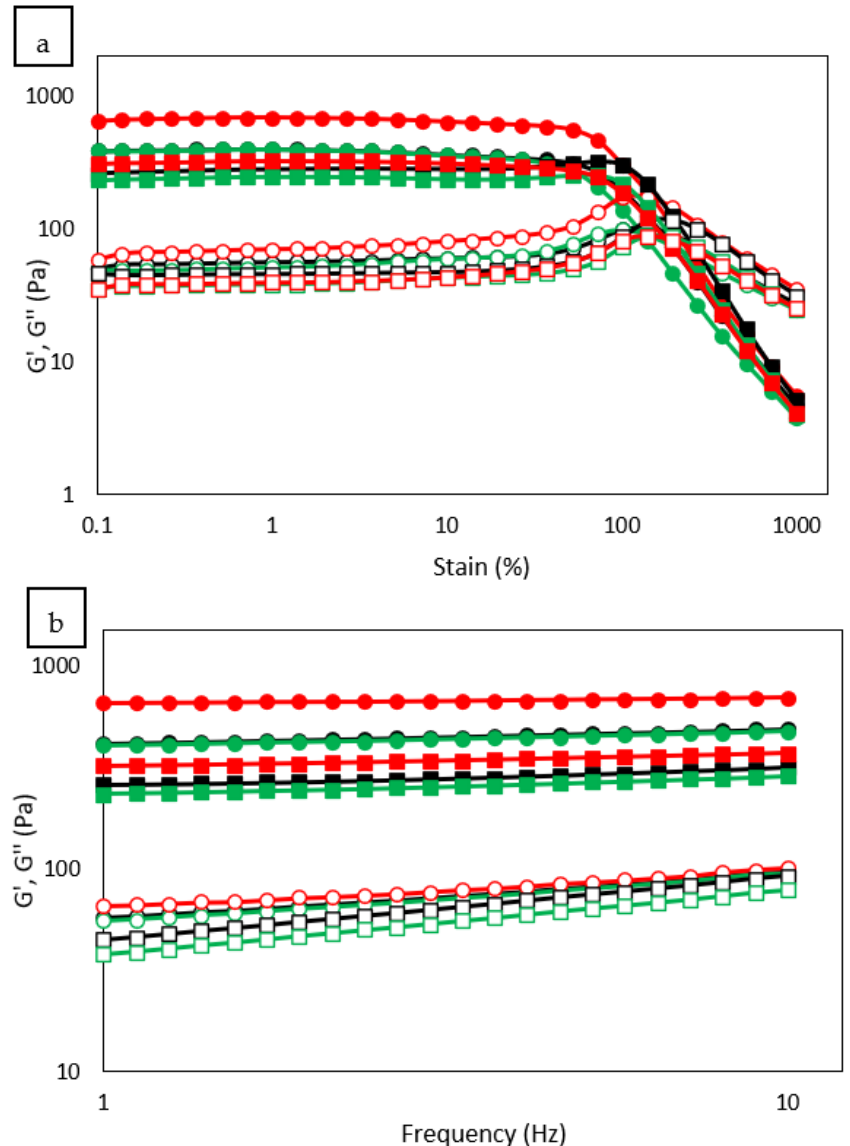
Figure 3. ( a ) Strain and ( b ) frequency sweeps of tef ( ■ □) and corn (● ○ ) flours. The elastic modulus (G ′ ) is represented by solid symbols and the viscous modulus (G ″ ) by open symbols. Black lines correspond to native samples, green lines to freeze dried samples and red lines to centrifuged samples.